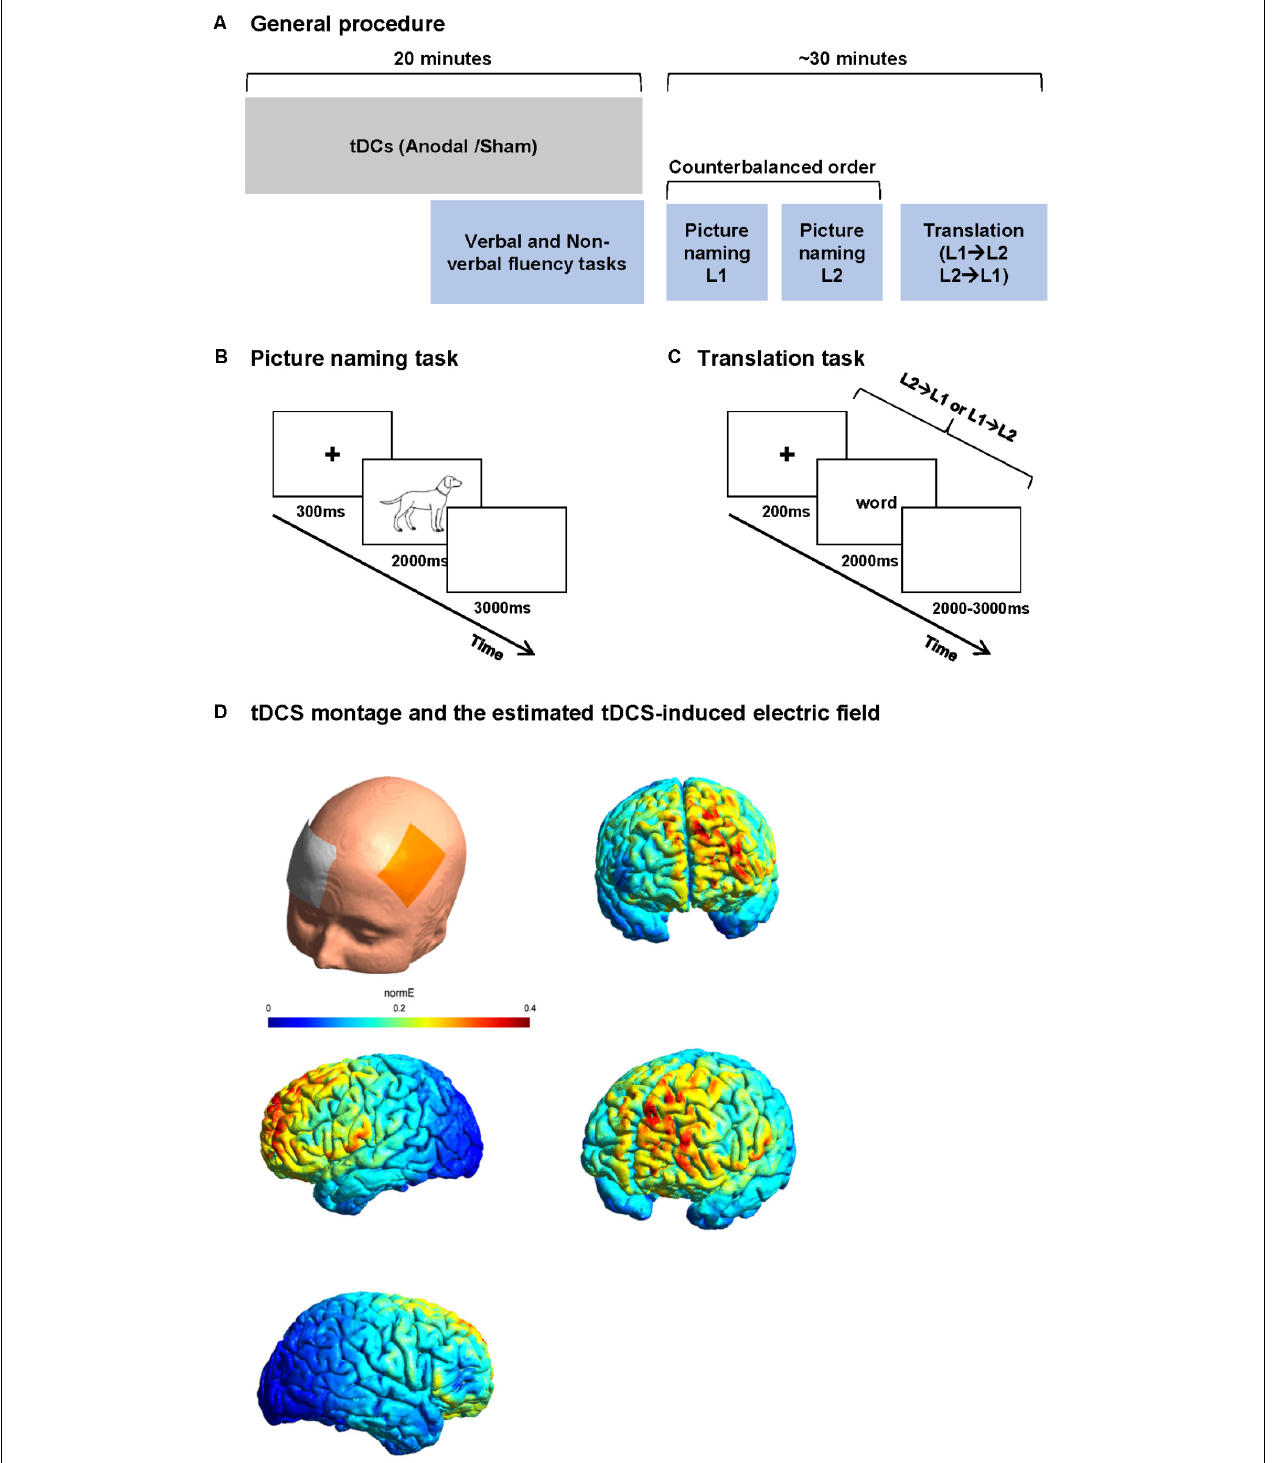
FIGURE 1 | Study procedure and tasks. (A) Study procedure: each participant participated in two sessions 1 week apart. In each session, participants received 20 min of anodal or sham tDCS. The participants performed verbal and non-verbal fluency task before the end of stimulation. After the stimulation, the participants performed two blocks of picture naming (in L1 and L2 in a counterbalanced order between subjects) and finally a word translation task. (B) Picture naming paradigm. Participants were asked to name the images presented on the screen as fast as possible. (C) Word translation task. Participants were randomly presented words in L1 or L2 and were asked to translate it to L2 or L1 as fast as possible. (D) An estimate of the electric field induced by our tDCS montage in the anodal condition.